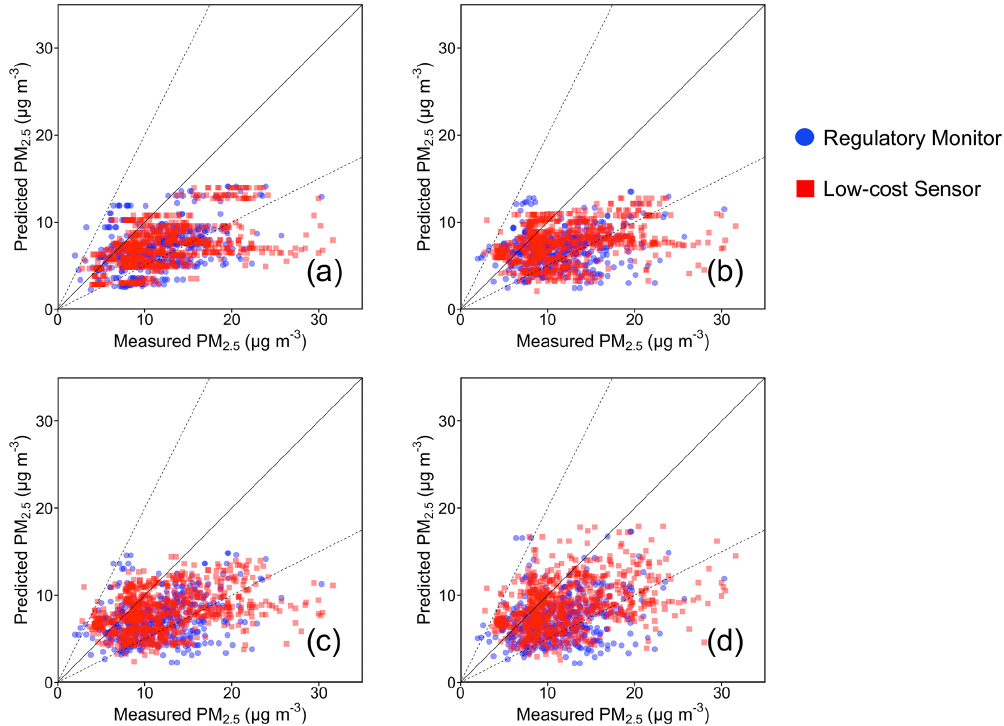
Figure 6. Comparison of daily average PMCAMx-v2.0-predicted concentrations of PM 2 . 5 with daily regulatory measurements and daily low-cost sensor measurements at (a) 36 × 36, (b) 12 × 12, (c) 4 × 4, and (d) 1km × 1km during July